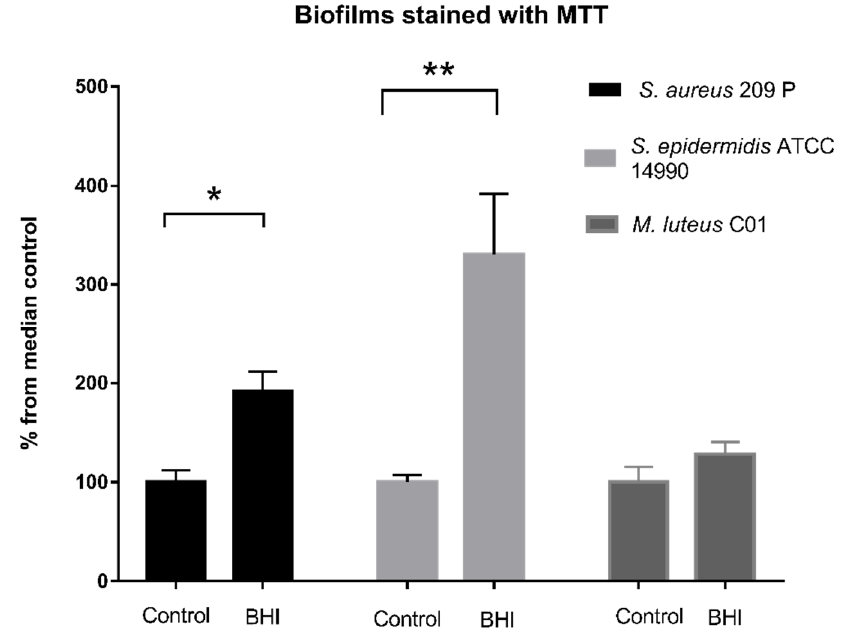
Figure 2. Biofilm growth on pellets placed in PAAG carrier with PS (control) and with nutrient medium (BHI). Mean relative values are indicated, error bars represent standard error of the mean, * p < 0.05, ** p < 0.001 according to Mann-Whitney test.